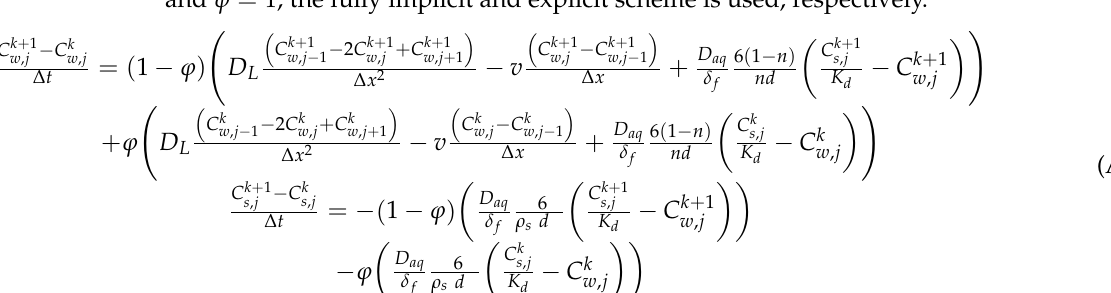
for shell 𝑝 = 2 to shell 𝑝 = 𝐿 − 1 a nd